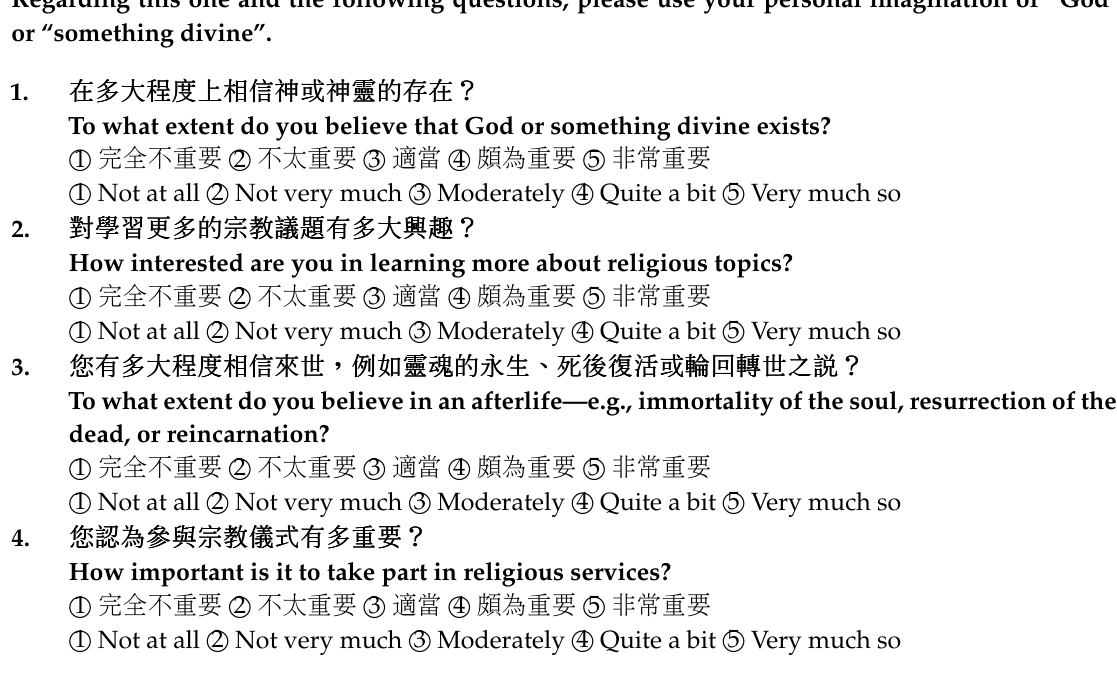
Figure A3. MIMIC model for CRS-15; * Items 01–15 refer to the Item 01–15 in Appendix D.